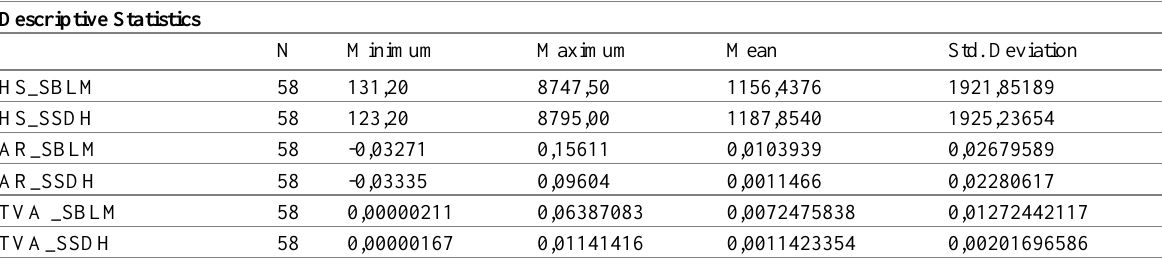
Table 4: Descriptive Statistics Test